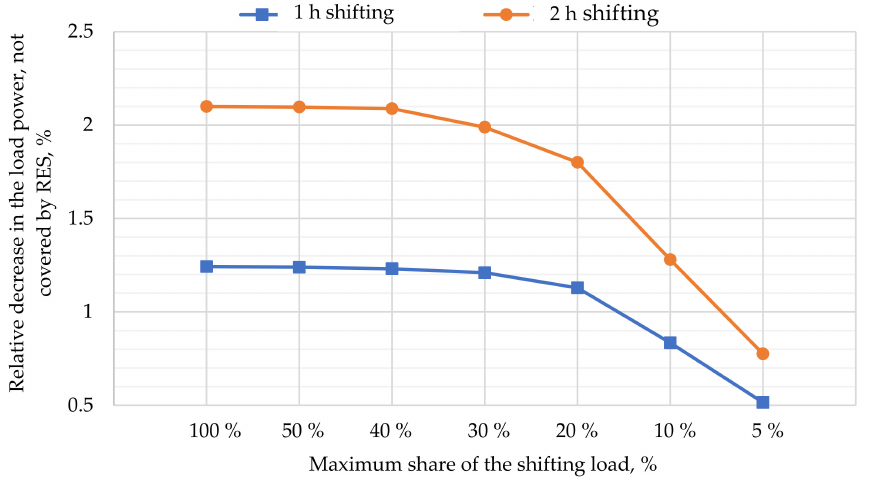
Figure 8. Dependence of the relative decrease in the load power, not covered by RESs, on the maximum share of the shifting load for two variants of the algorithm